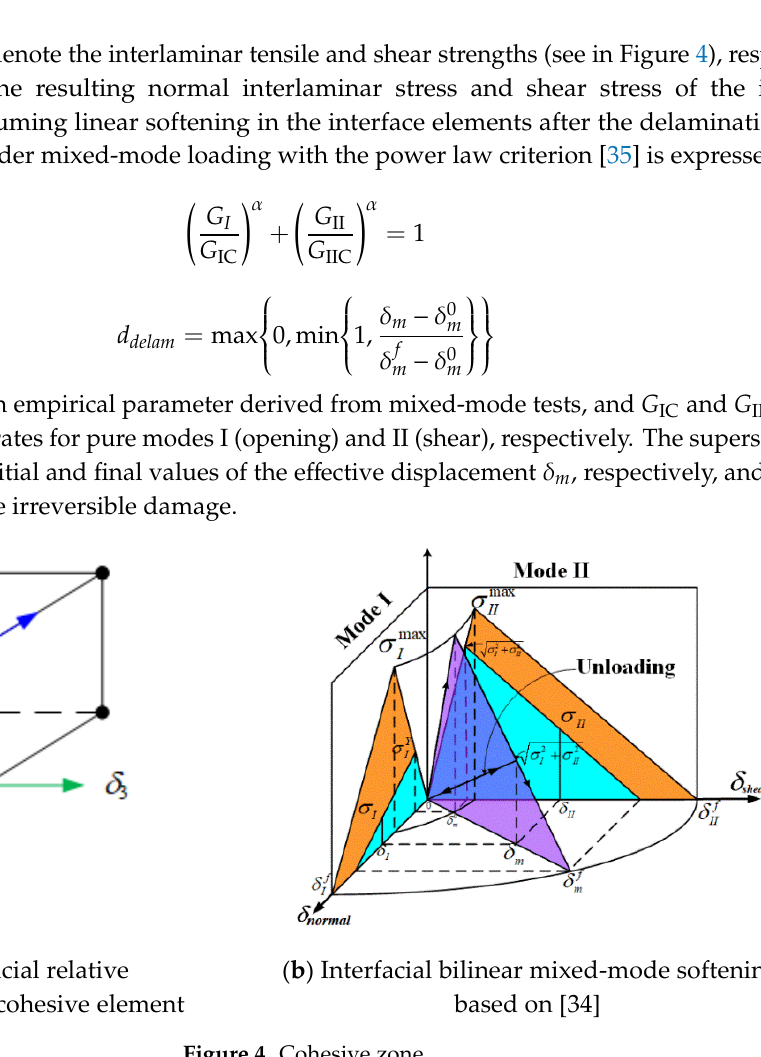
Figure 4. Cohesive zone.